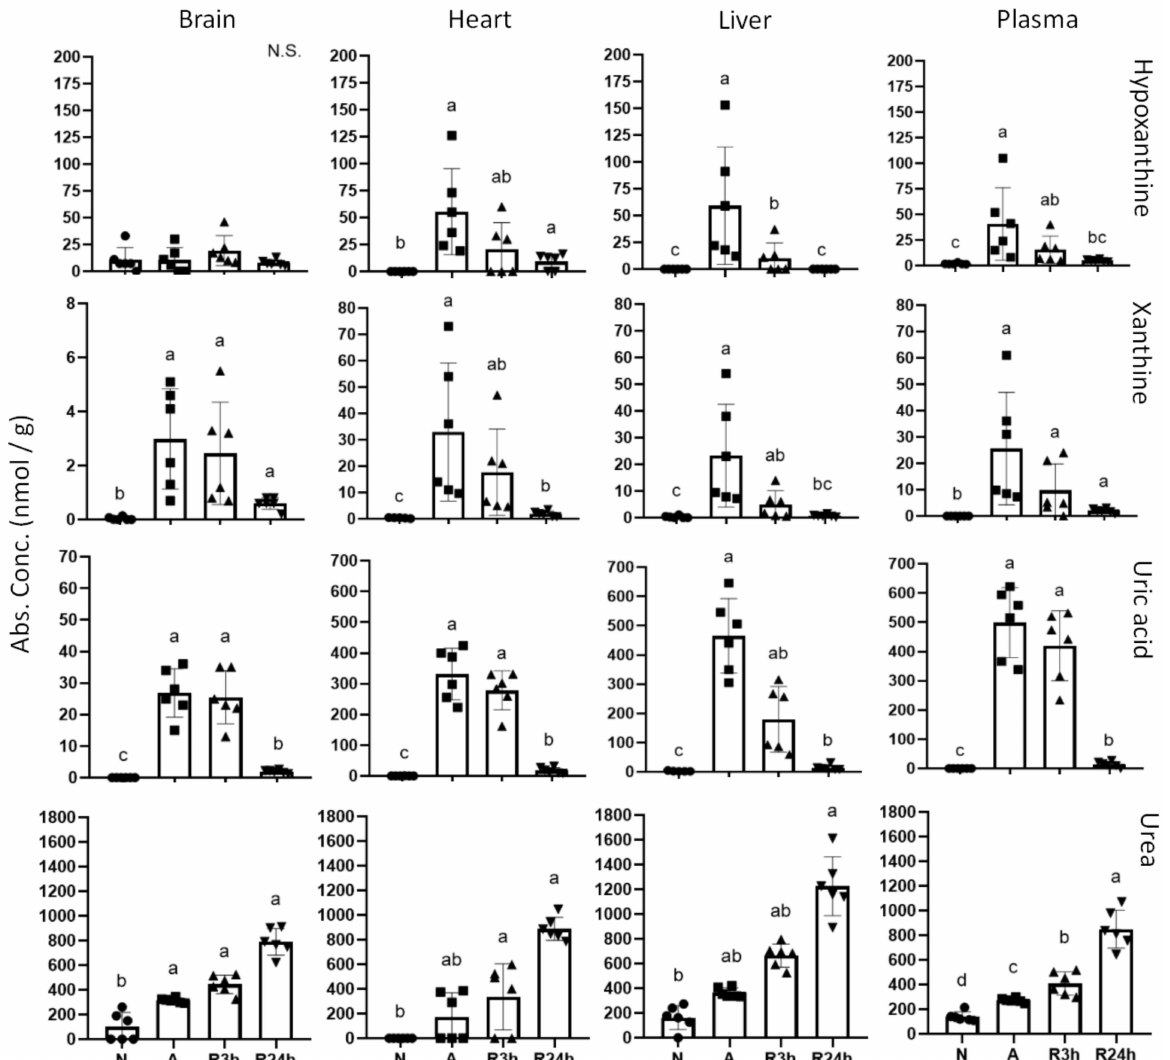
Figure 11. Purine metabolism. Graphs of absolute concentrations of metabolite intermediates hypoxanthine, xanthine and end-product uric acid, as well as urea for all tissues. N, normoxia (control); A, anoxia; R24h, 24 h reoxygenation; R3h, 3 h reoxygenation. Different letters indicate statistical differences between groups calculated using one-way ANOVA with Tukey’s post-hoc ( p -value ≤ 0.05). Note that y-axis limits are different. Data are presented as means ± S.D. Values as reported by